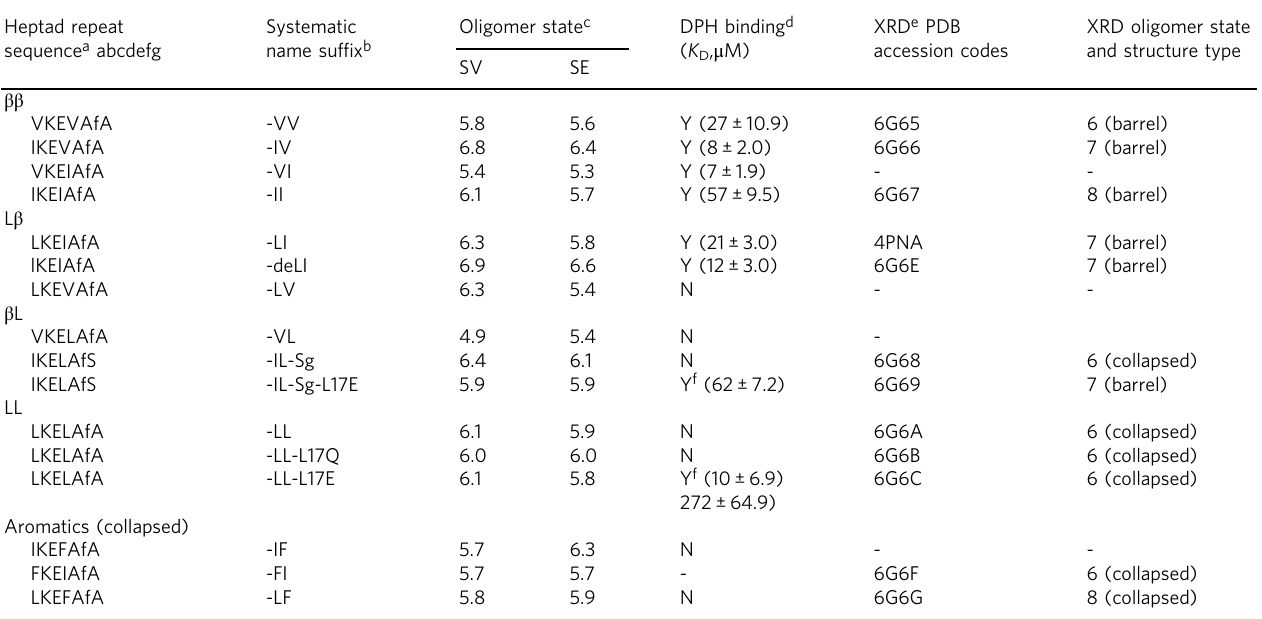
Table 1 Designed peptides and summary of biophysical data Heptad repeat sequence a